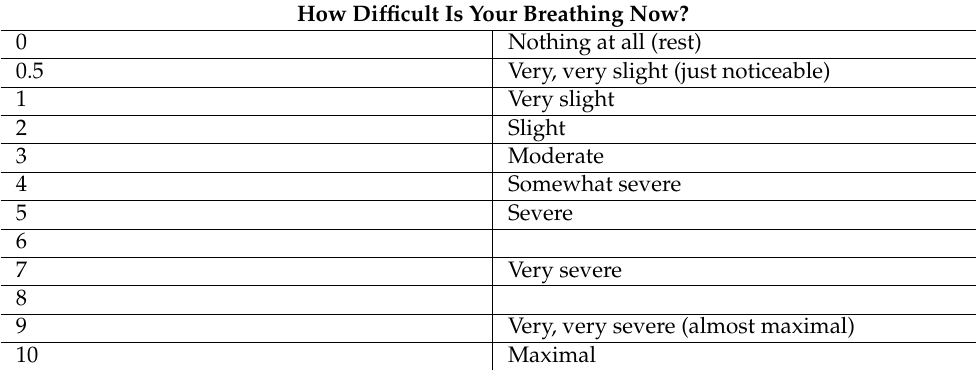
Table 2. Modified Borg Dyspnea Scale.